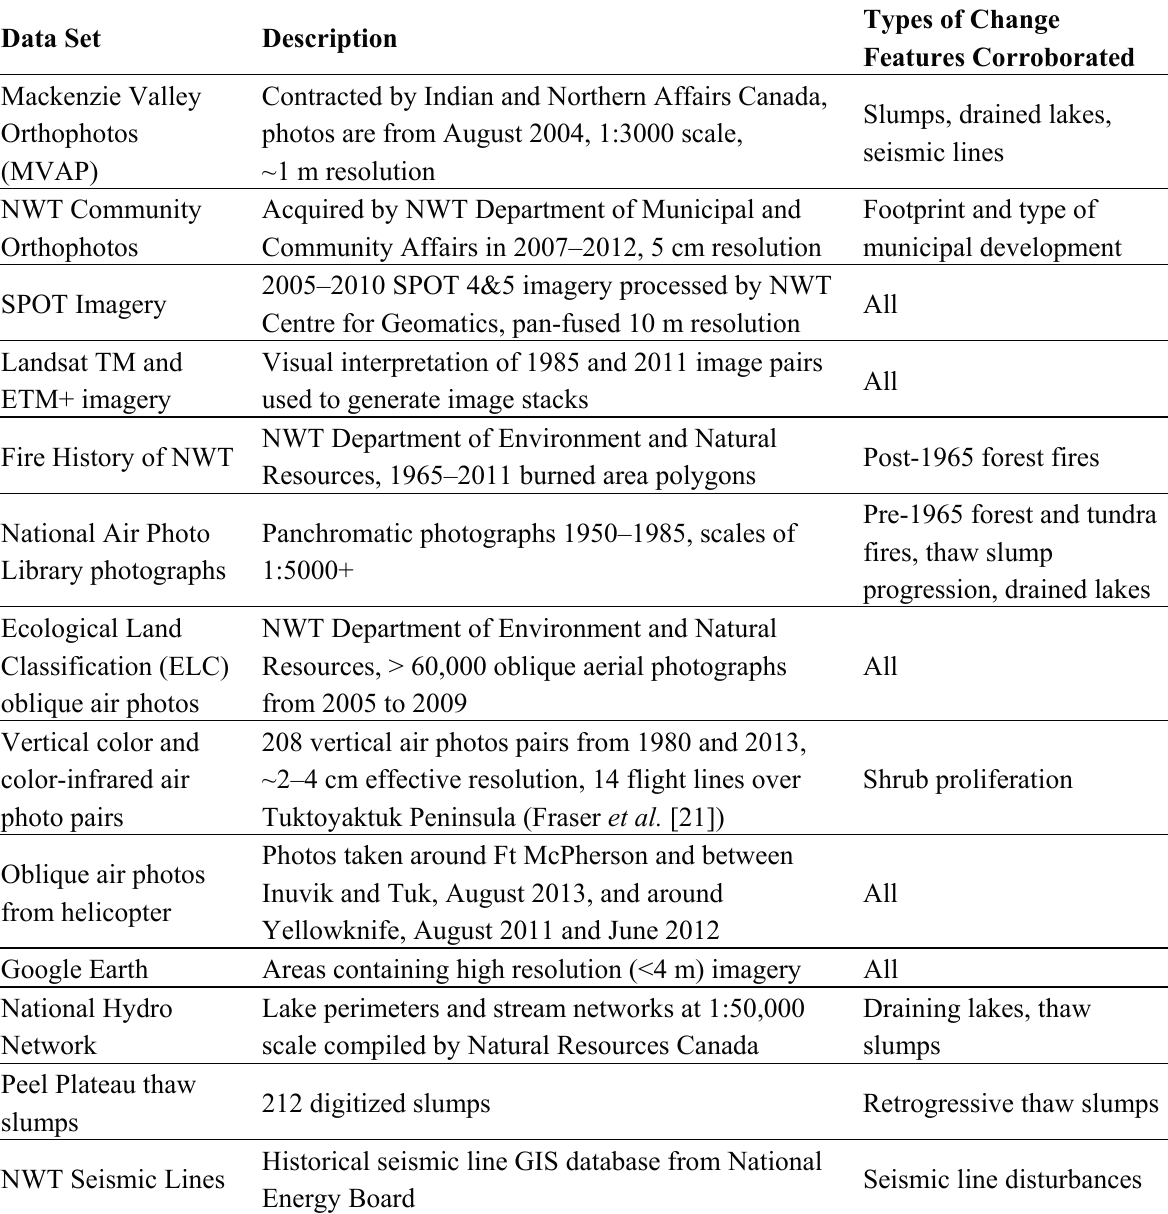
Table 1. Reference data used to identify and corroborate landscape changes observed in the Landsat Tasseled Cap trend